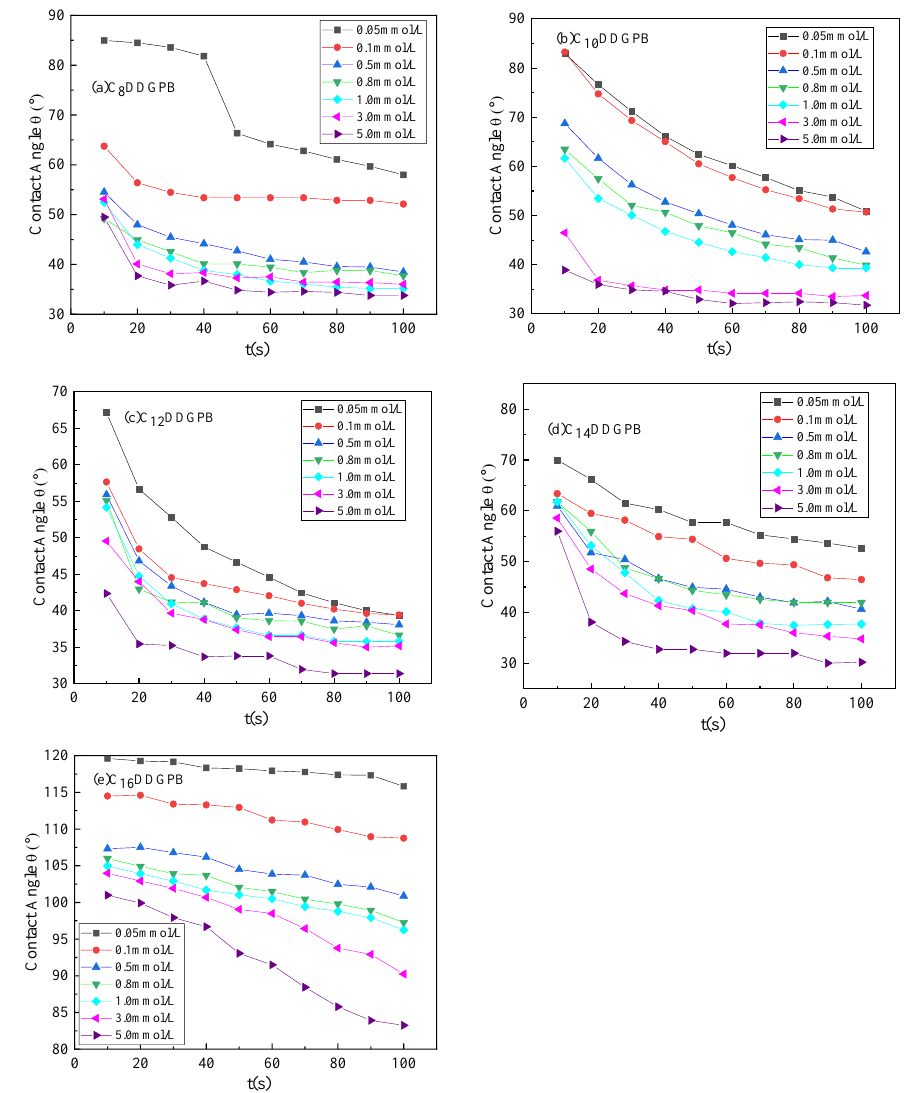
Figure 5. Effect of the surfactant concentration on the contact angle of a PTFE surface for ( a ) C 8 DDGPB, ( b ) C 10 DDGPB, ( c ) C 12 DDGPB ( d ) C 14 DDGPB, and ( e ) C 16 DDGPB.